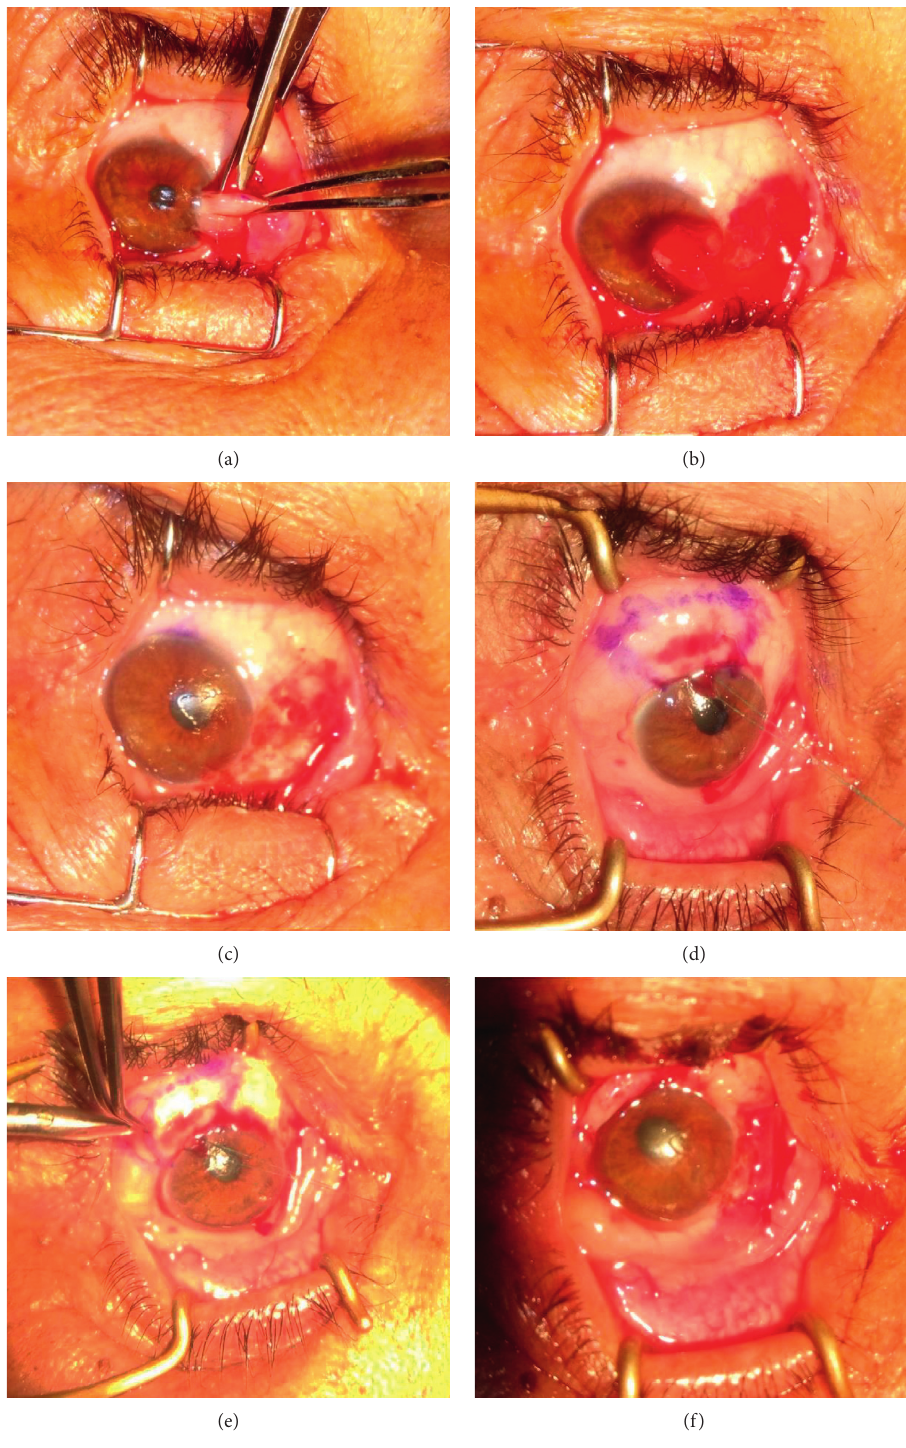
Figure 1: Basic operative technique: (a) dissection of the pterygium from the scleral bed; (b) complete separation of body of pterygium from the scleral bed; (c) bare sclera and cornea after pterygium excision; (d) marking of the conjunctival autograft; (e) dissection of the conjunctival autograft from its bed; (f) suture of the graft to the bare